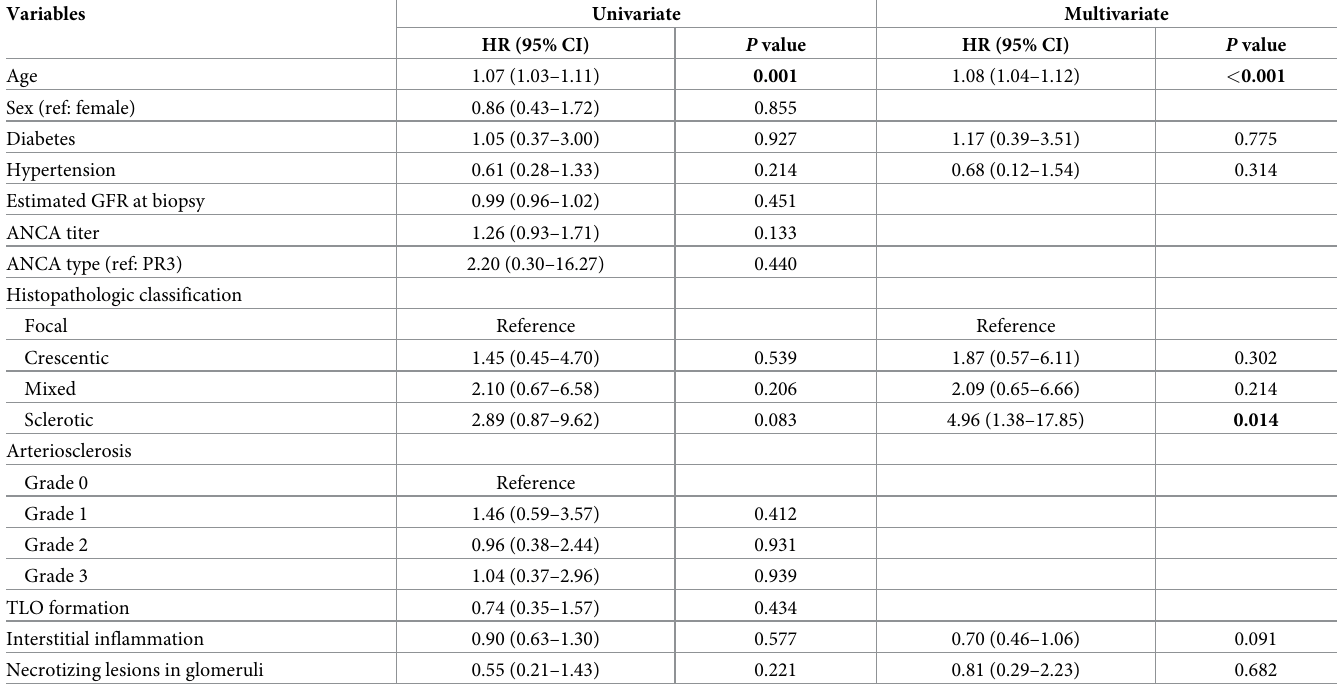
Table 4. Predictors for patient death in Cox proportional hazards